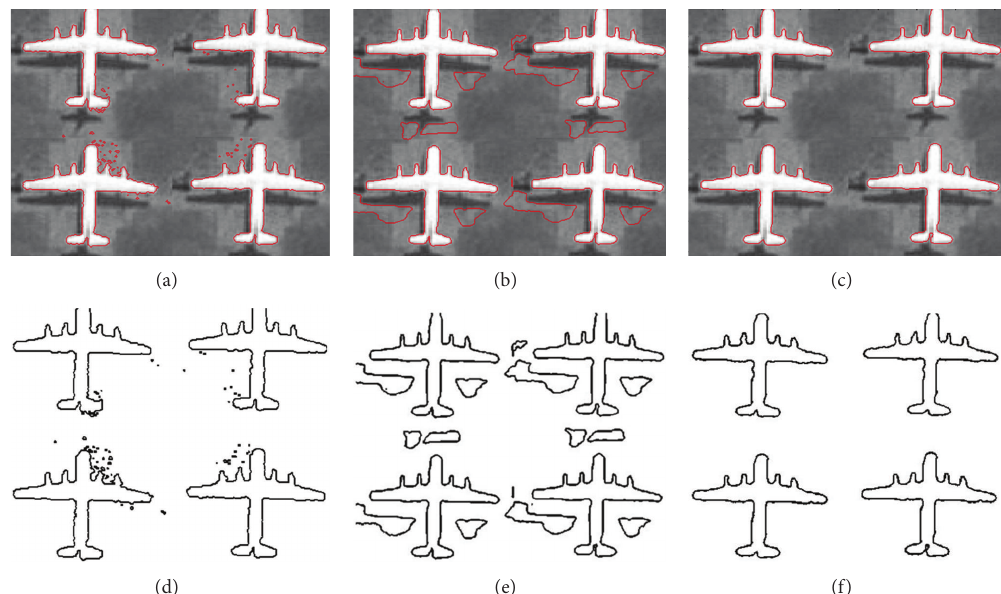
Figure 1: The segmentation results of the aircraft composite image: (a) and (d) results using CV model, (b) and (e) results using LBF model, and (c) and (f) results using the new